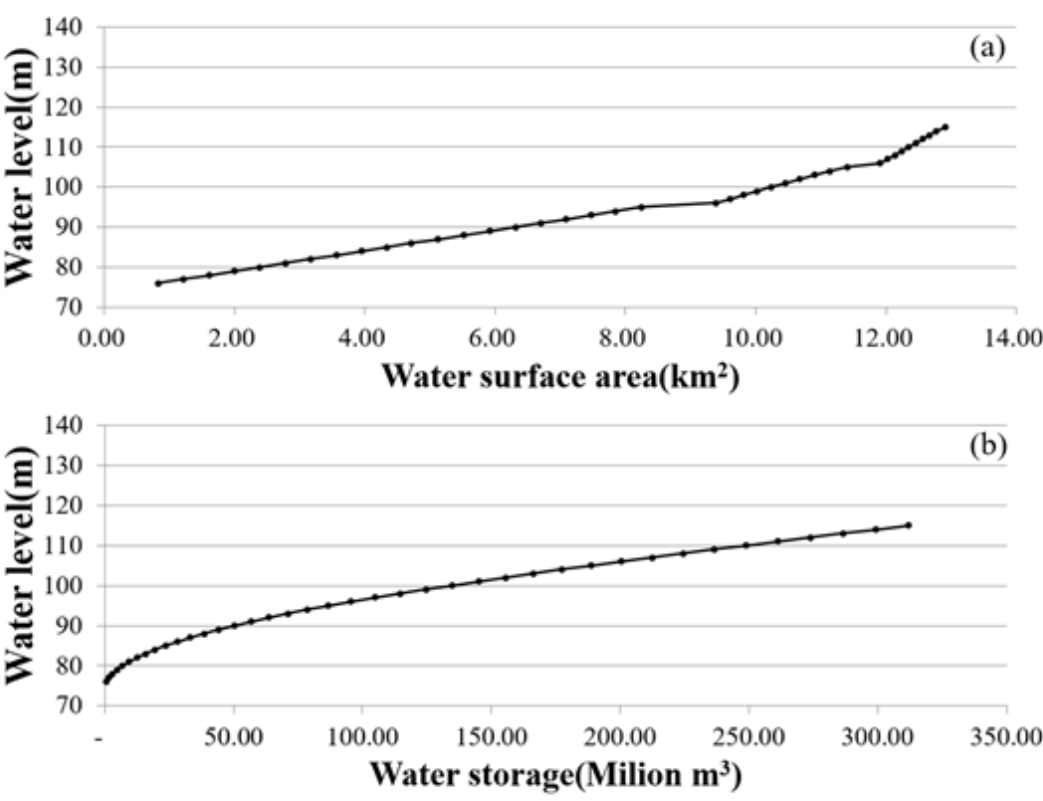
Figure 4. The water level–surface area–storage relationship from the digital elevation model of the Hwanggang Dam reservoir. ( a ) The water level–surface area relationship for the satellite-based water surface area. ( b ) The water level–storage relationship for the characteristic analysis of the